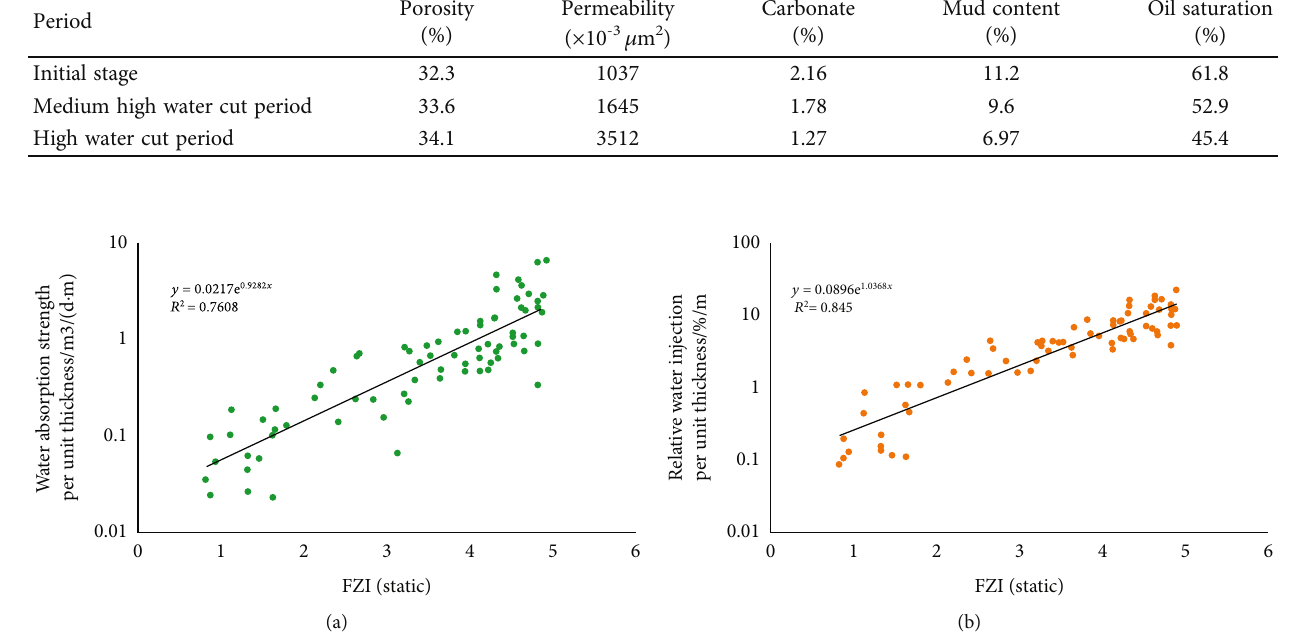
Figure 6: Correlation analysis between FZI and water absorption pro fi le data. (a) The relationship between fl ow band index and water absorption strength. (b) Relationship between fl ow zone index and relative water injection per unit